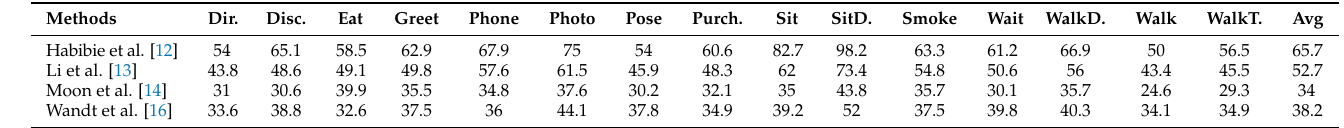
Table 1. Summary of performance on Human3.6 Protocol #1 (MPJPE: